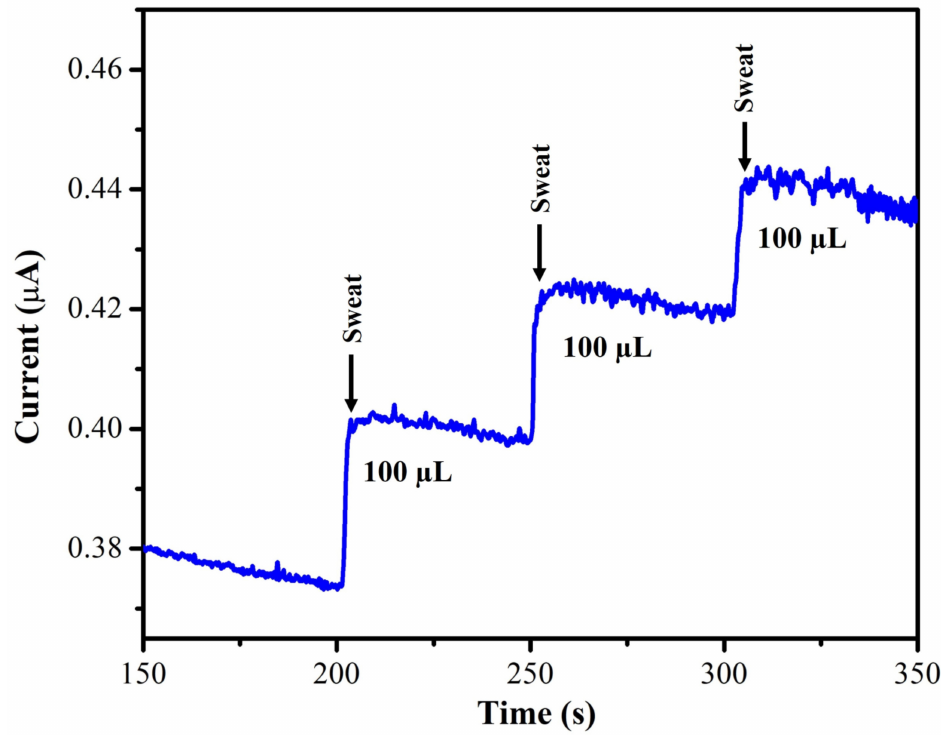
Figure 15. NIC determination in real-world sample (sweat) by amperometry at 1 V in 0.1 M phosphate buffer (pH 7.4) with a rotation rate of 750